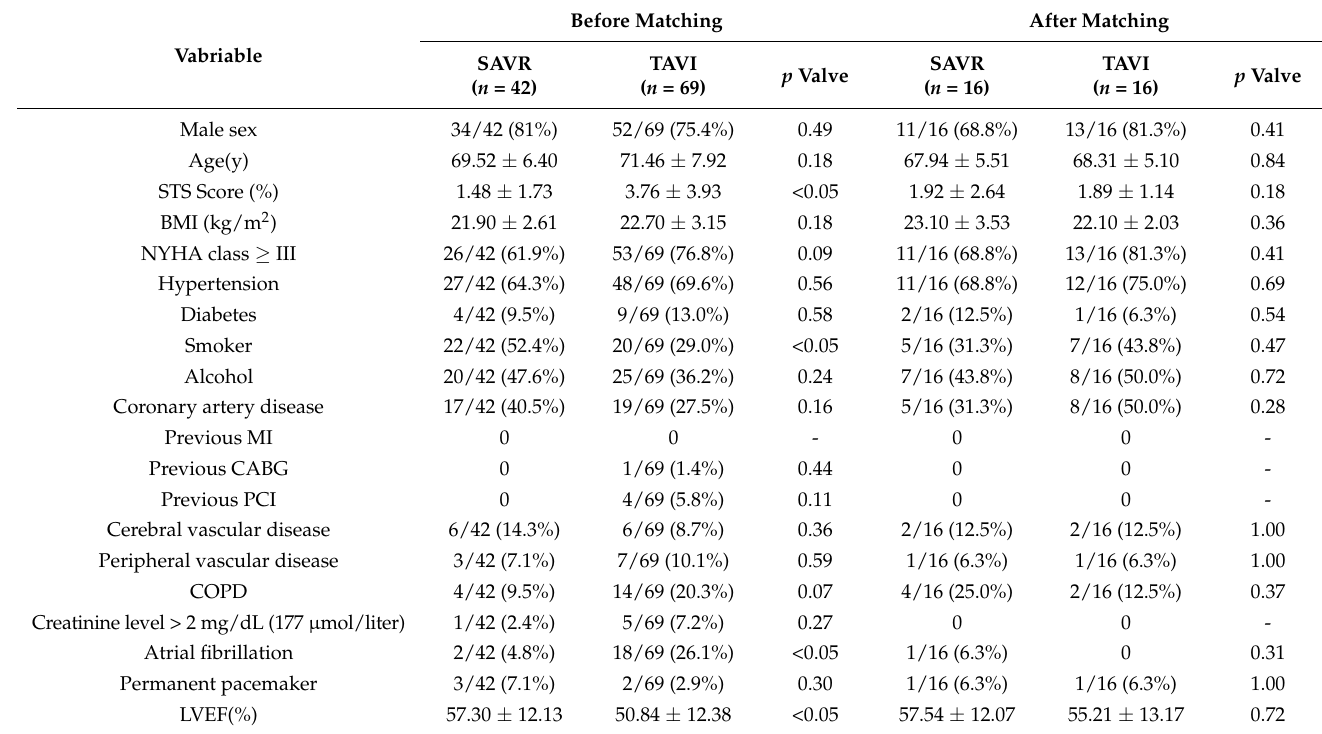
Table 1. Baseline data of TAVR and SAVR group before and after propensity score matching. (BMI, body mass index; STS Score, Society of Thoracic Surgeons Score; MI, myocardial infarction; CABG, coronary artery bypass grafting; PCI, percutaneous coronary intervention; COPD, chronic obstructive pulmonary disease; LVEF, left ventricular ejection